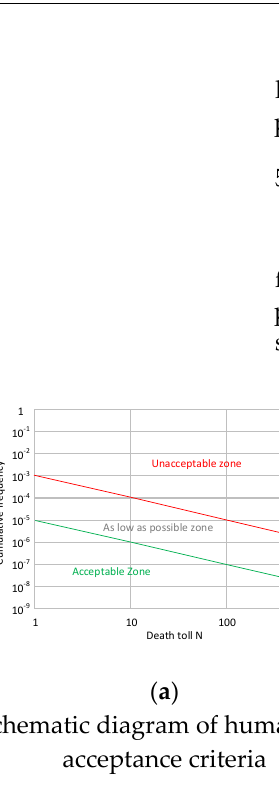
Figure 9. Schematic diagram of risk acceptance criteria.